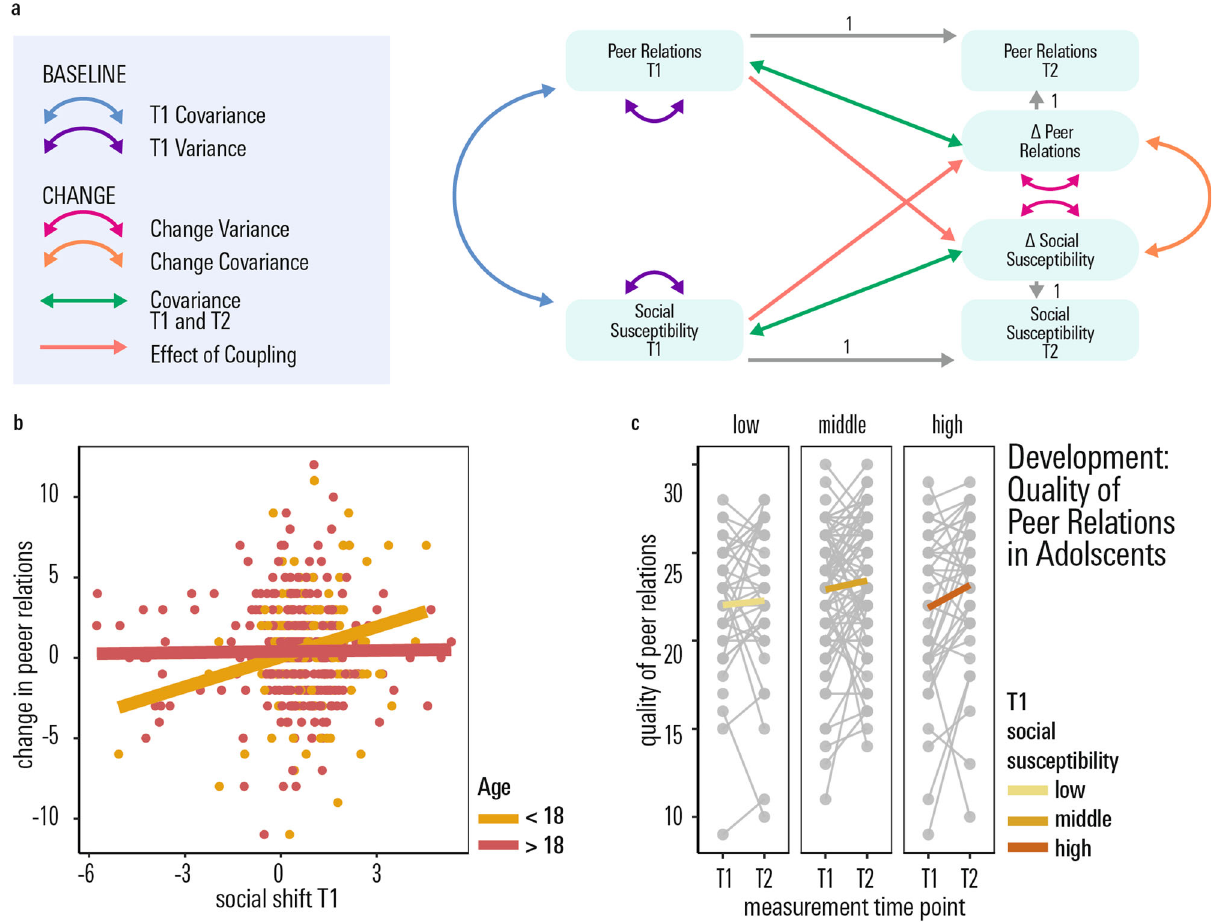
Fig. 3 Social susceptibility and the development of peer relations. a Schematic of the latent change score model of the longitudinal development of social susceptibility in our task, the longitudinal development of real-life psycho-social functioning (perceived quality of peer relations) from baseline to long follow- up (~1.5 years later) as well as their co-development. Social susceptibility at time point 1 signi fi cantly predicts an increase in the quality of peer relationships within the follow-up period. b This positive association was driven by the younger (< 18 years old) people in our sample, but was not signi fi cant in those aged 18 or older. The full set of parameter estimates is included in the Supplementary Table 1. Error bands denote the 95% con fi dence level interval. c Change in the quality of peer relations in the adolescent subgroup (<18 years), plotted as a function of T1 Social susceptibility. T1 measurement time point 1, baseline assessment; T2 measurement time point 2, follow-up assessment after ~1 – 5 years. Source data are provided as a Source Data fi